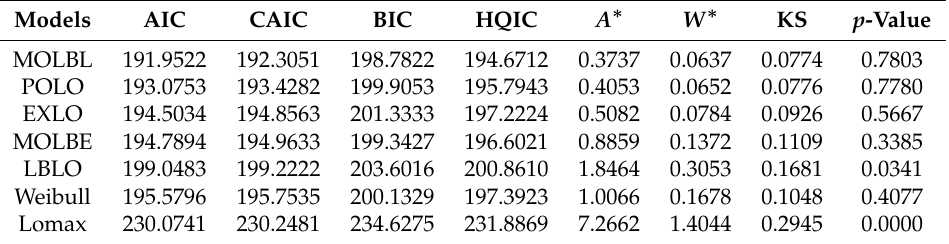
Table 12 indicates the values of the AIC, CAIC, BIC, HQIC, A ∗ , W ∗ , KS and p -value of the considered models. Table 12. Some criteria and goodness of fit measures for Data set 3.